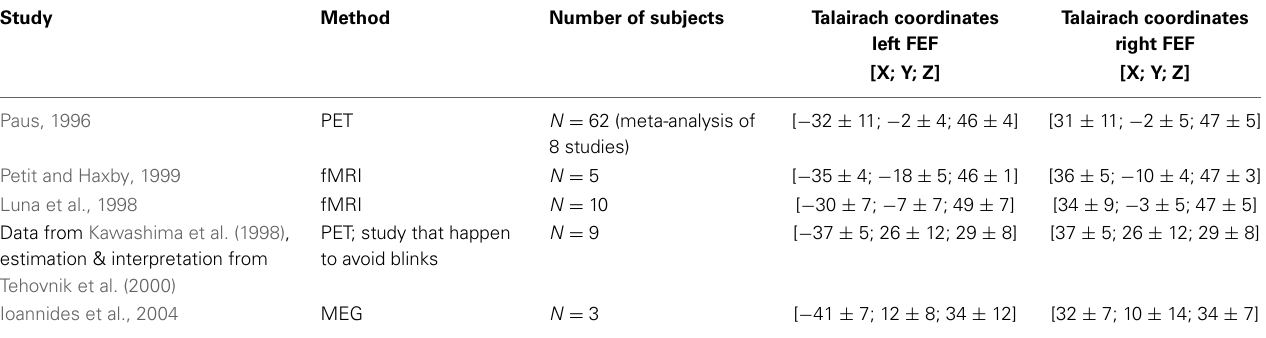
Table 2 | Coordinates of left and right FEF from a few neuroimaging